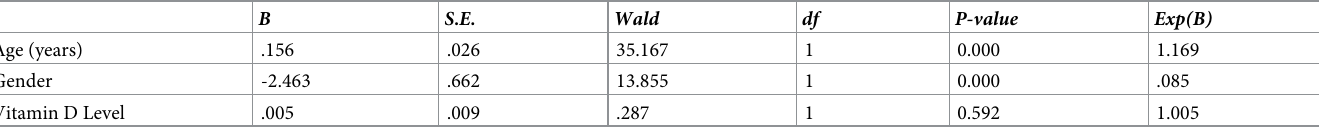
Table 3. Logistic regression for association of osteoporosis with age, gender, and vitamin D